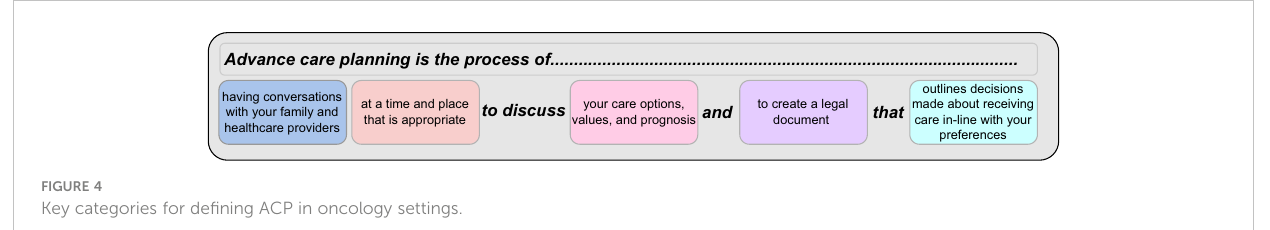
FIGURE 4 Key categories for de fi ning ACP in oncology